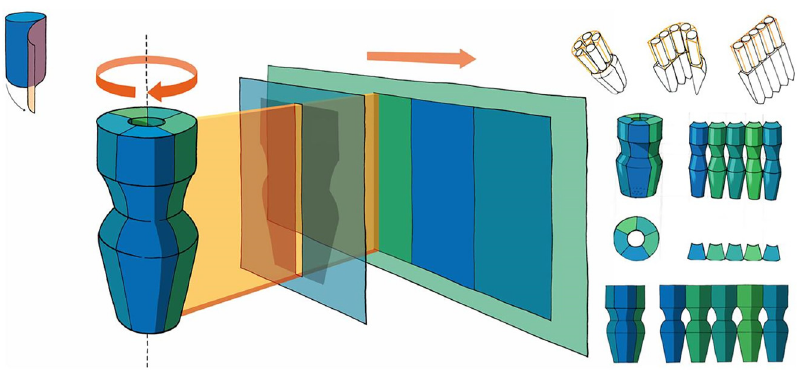
Figure 4: Design – a new way to look at old molecules: unrolling the surface – transfer of the photographic principle of 360-degree rotation of the camera to the case of taking a panorama of a protein surface. The final concept is drawn in the centre of the image, the first studies are shown smaller on the right side ( © 2022 Spalvieri et al., CC BY 4.0 [11]).